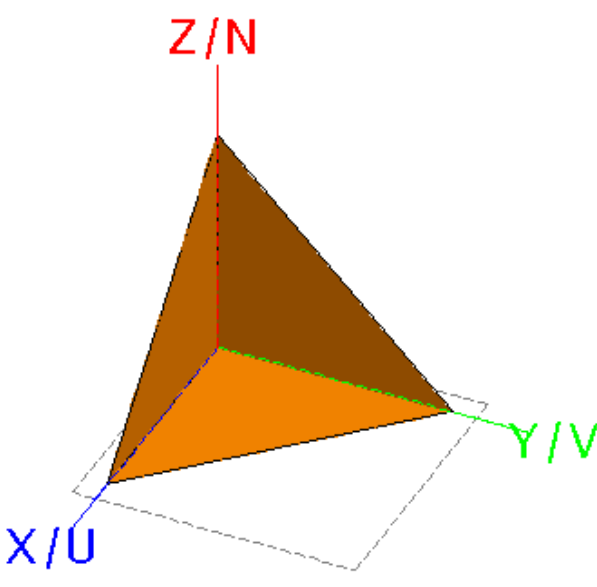
Figure 1. Triangular trihedral corner reflector.